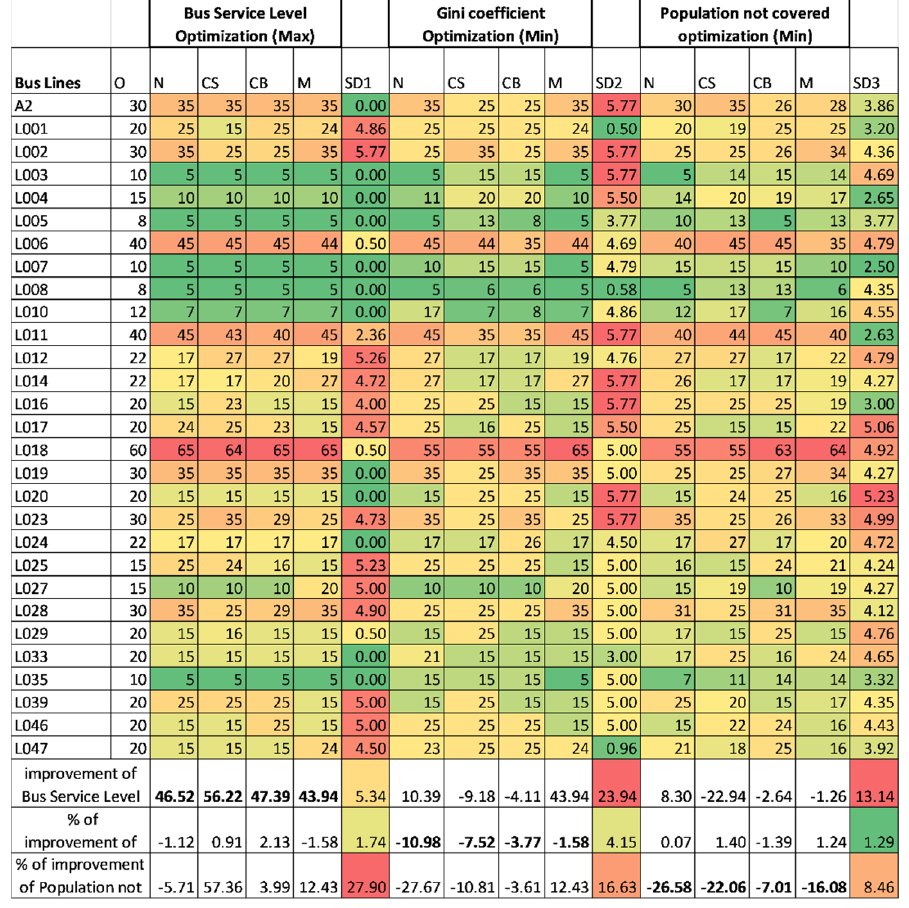
Figure 10. Optimization results (in Minutes). [N] Neighbourhoods; [CS] Census sections; [CB] Cadastral blocks; [M] 400 × 400 m mesh. [SD1], [SD2], and [SD3] Standard Deviation (of minutes) for each line for BSL, Gini coefficient, and PNC, respectively.